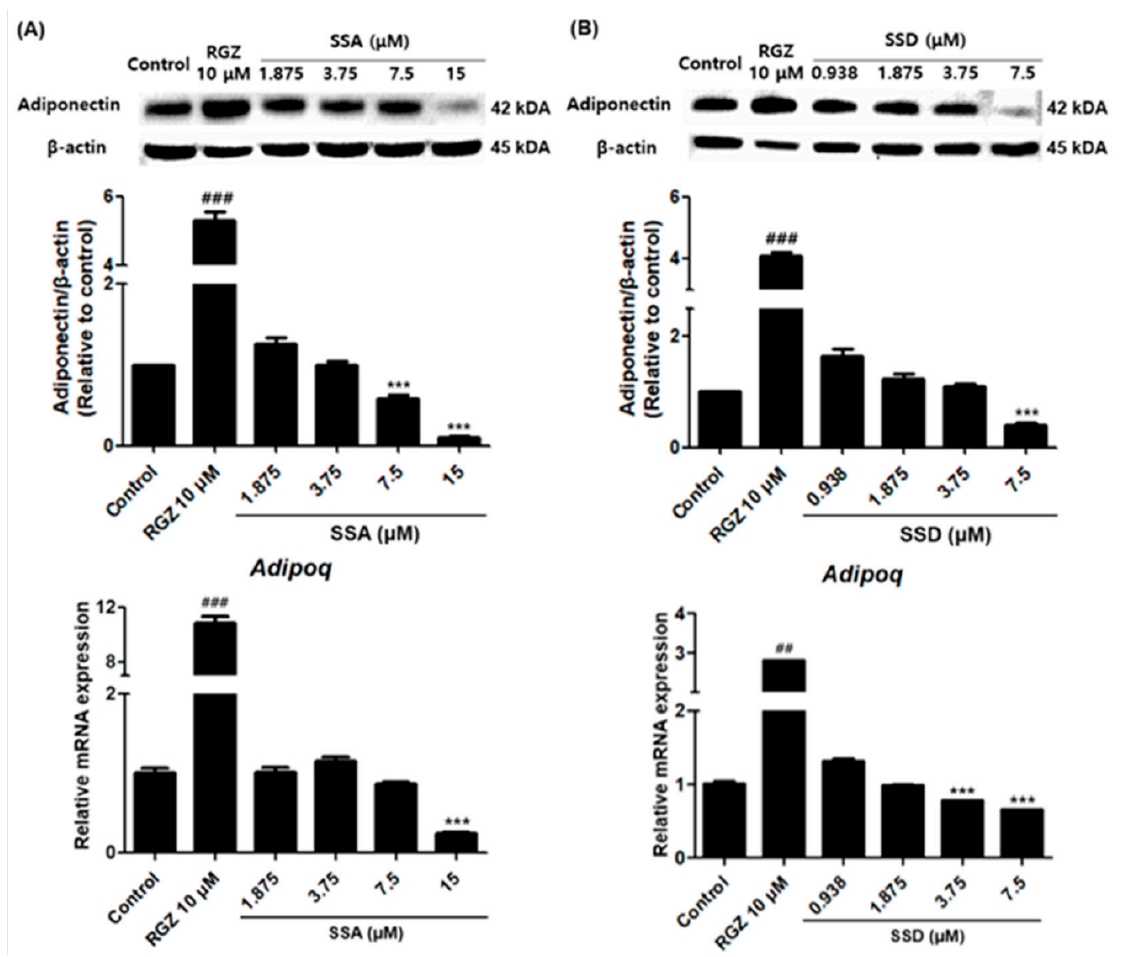
Figure 5. Effect of SSA ( A ) and SSD ( B ) on the expression protein and mRNA levels of adiponectin in 3T3-L1 cells as measured by Western blot and quantitative real-time PCR, respectively. Results are shown as a relative of control (0.5% DMSO) values and RGZ (rosiglitazone) was used as a positive control for this experiment. β -actin was used as a loading control and Gapdh was used as a house keeping gene. Target gene mRNA levels were normalized to Gapdh using the 2- ∆∆ Ct method. Data are mean ± standard error of the mean (SEM) of three independent experiments. Results are mean ± standard error of the mean (SEM) of triplicate experiments. *** p < 0.001, ## p < 0.01, ### p < 0.001, compared with control, #: increased compared to control, *: decreased compared to